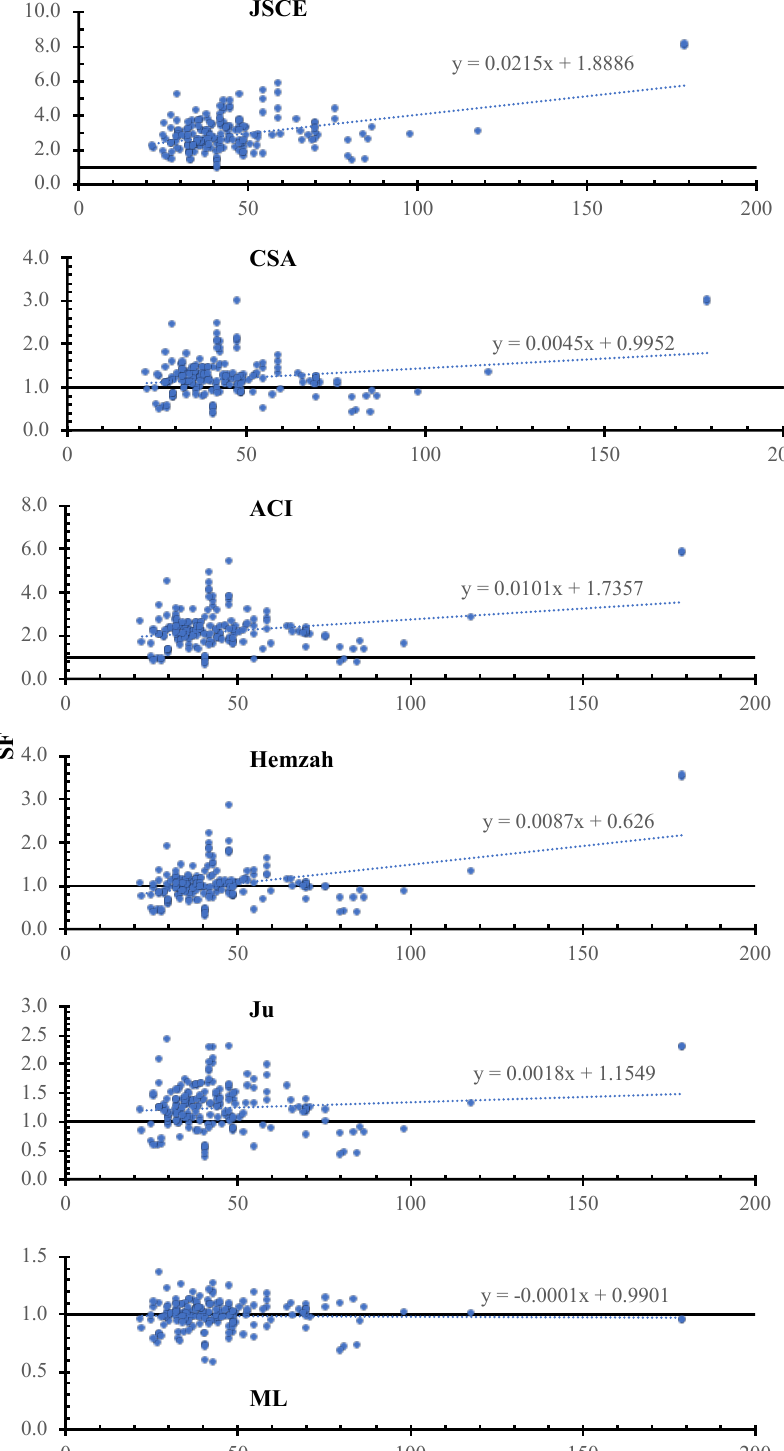
Figure 7. SF calculated using various models versus